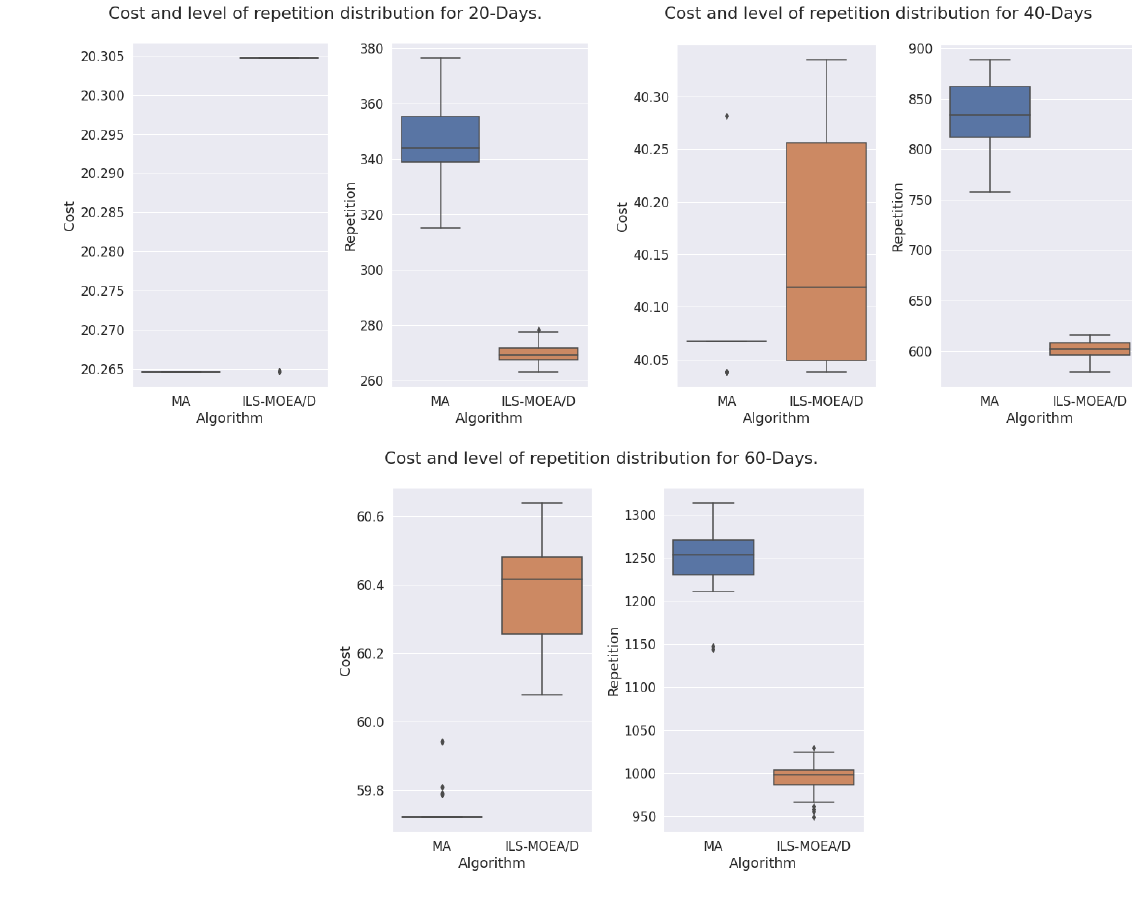
Figure 1. Boxplot representation of the values obtained by memetic algorithm (MA) and iterated local search (ILS)-multi-objective evolutionary algorithm based on decomposition (MOEA/D) for both objective functions, i.e., cost and level of repetition of specific courses and food groups, considering menu plans for n = 20 ( upper-left ), n = 40 ( upper-right ) and n = 60 ( bottom )